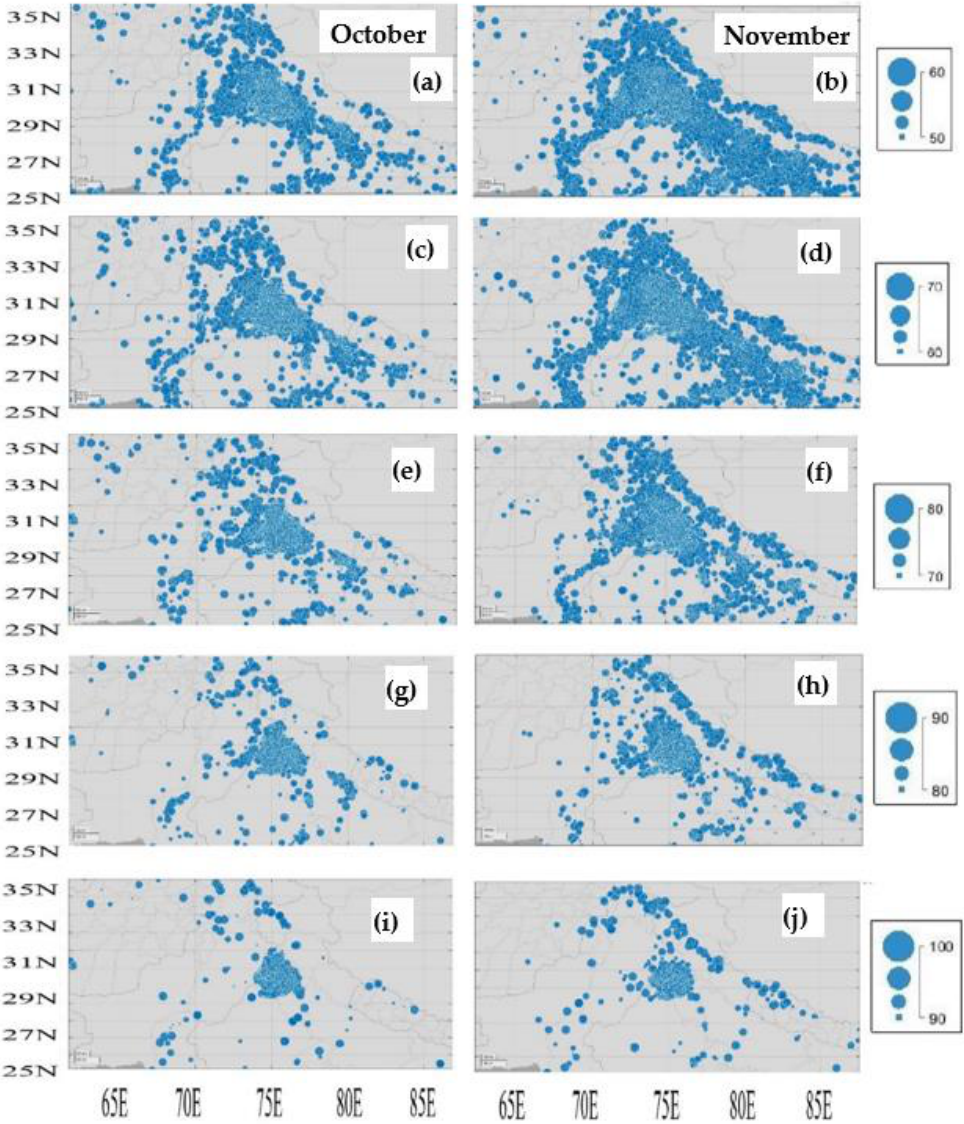
Figure 3. Spatial distribution of Fire confidence from 2002 to 2019 for October and November ( a , b ) ≥ 50 and ≤ 60, ( c , d ) ≥ 60 and ≤ 70, ( e , f ) ≥ 70 and ≤ 80, ( g , h ) ≥ 80 and ≤ 90, ( i , j ) ≥ 90 and ≤ 100.